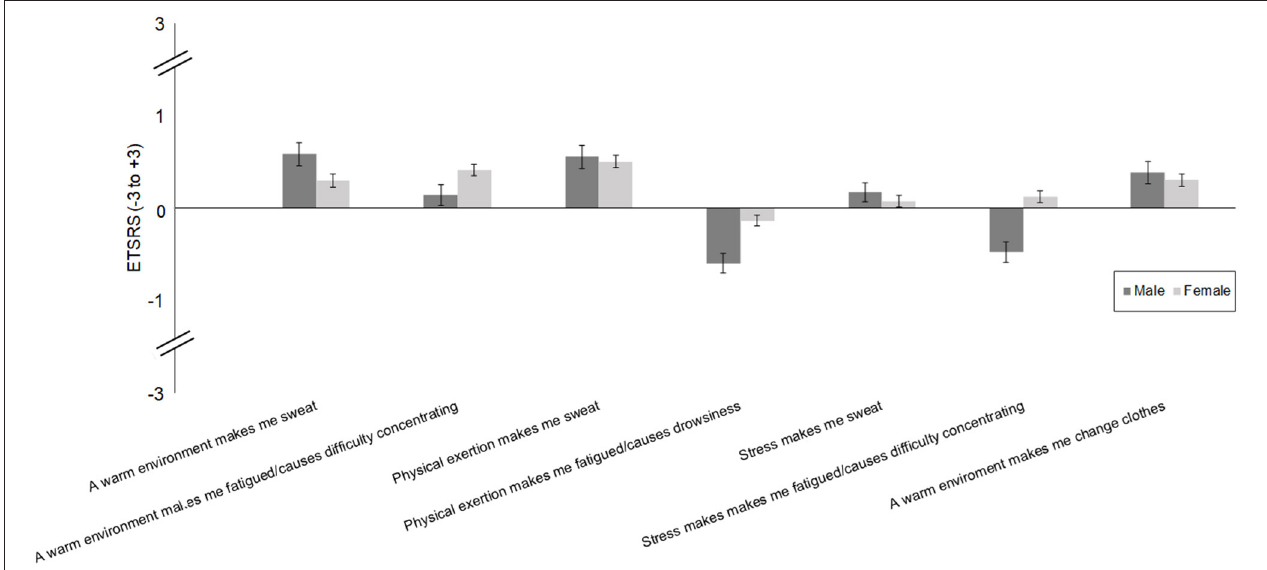
FIGURE 1 | Autonomic and behavioural thermoregulation [Experienced Temperature Sensation and Regulation Survey (ETSRS)] in individuals with self-reported male vs. female sex.